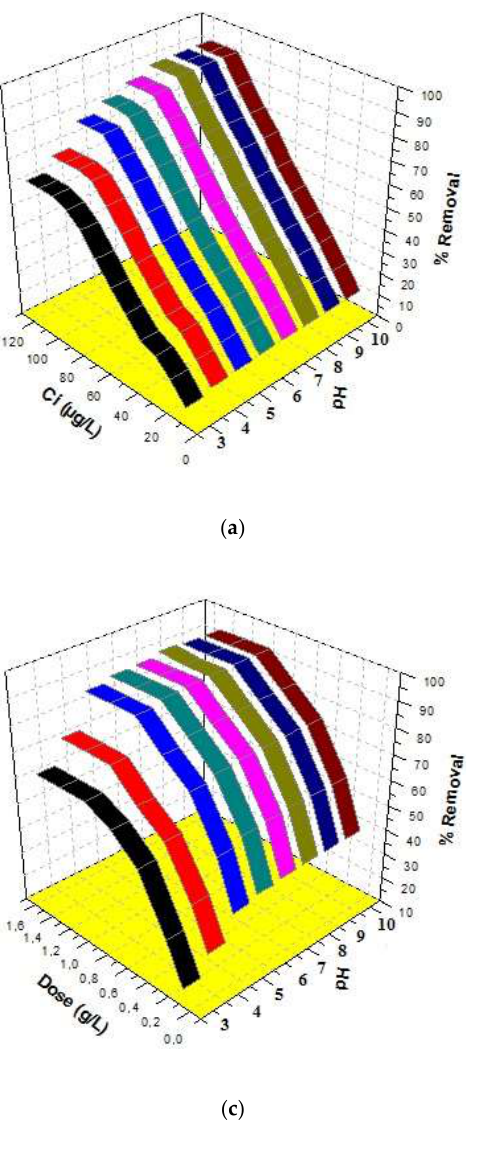
Figure 5. Three-dimensional plots for triclosan removal: ( a ) %removal vs. Ci vs. pH, ( b ) %removal vs. time vs pH, ( c ) %removal vs. dose vs pH and ( d ) %removal vs temperature vs. pH.